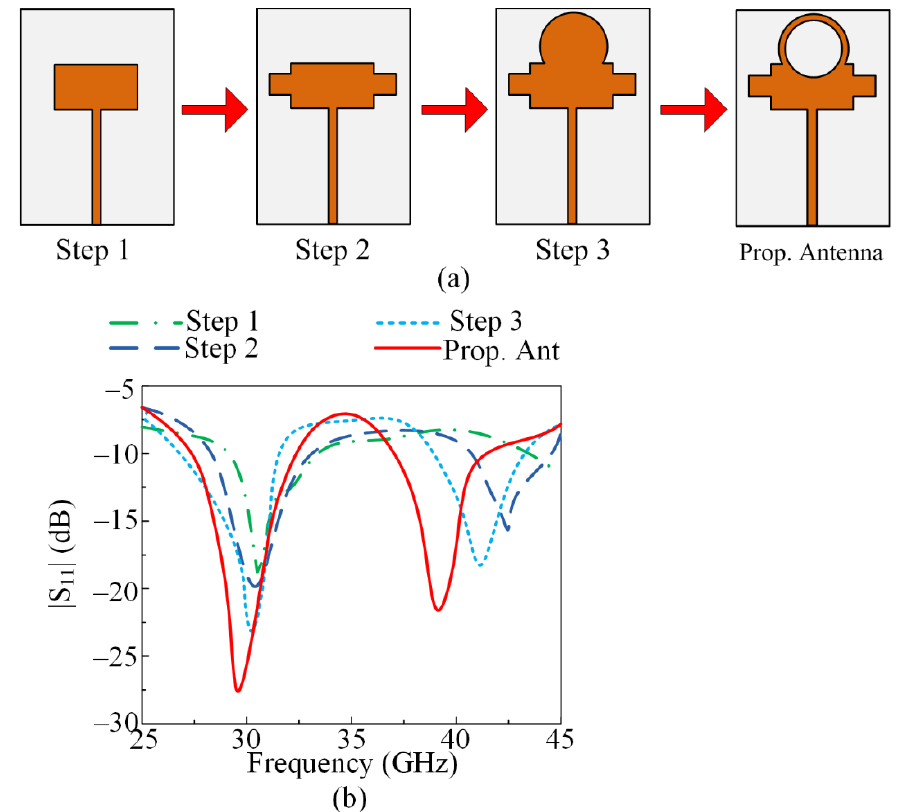
Figure 2. ( a ) Design evolution of proposed dual-band antenna and ( b ) S-parameter graph of various Figure 2. (a) Design evolution of proposed dual-band antenna and (b) S-parameter graph of various design design steps.